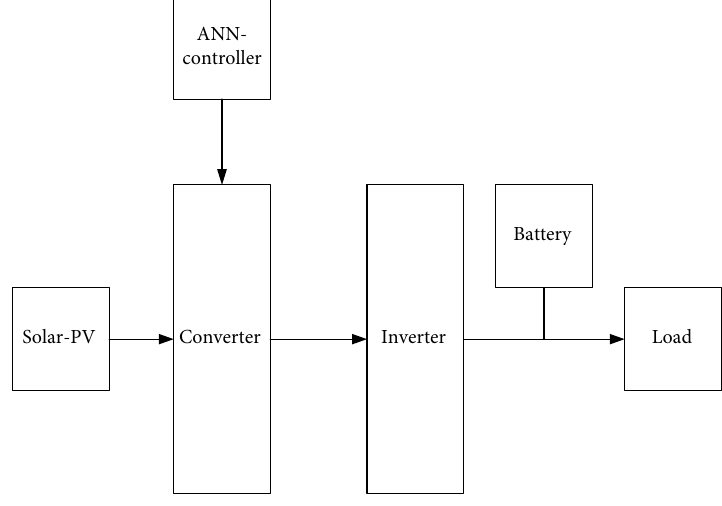
Figure 3: Con fi guration of the power management system.